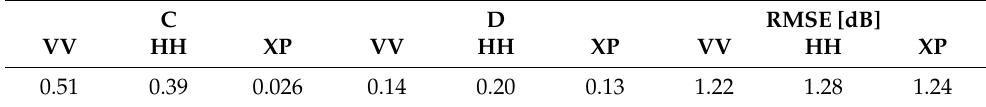
Table 3. WCM calibration